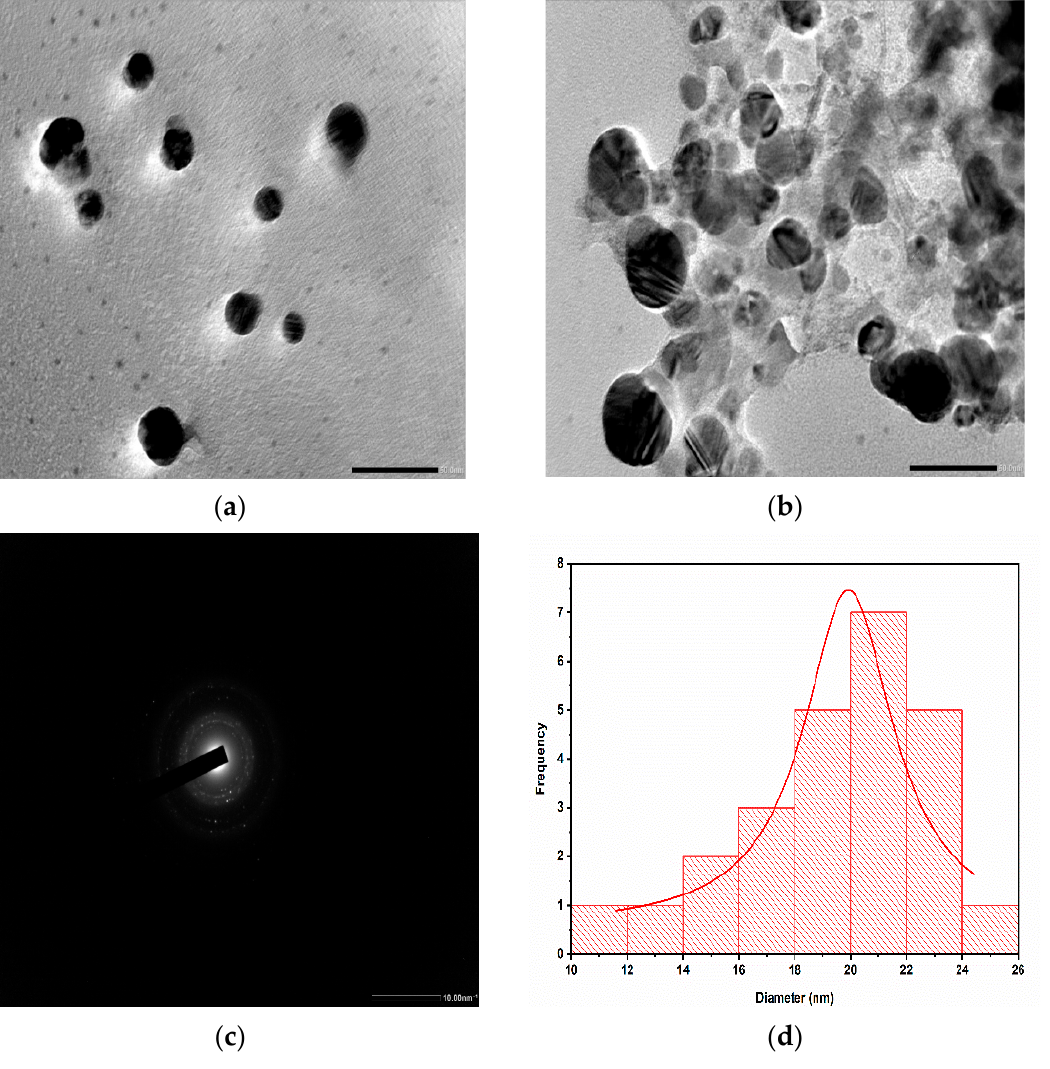
Figure 5. ( a , b ) HRTEM images of AgNPs in diverse magnification at ( a ) 20 nm scale ( b ) 50 nm scale ( c ) SAED pattern at 10 nm − 1 ( d ) the particle histogram . Table 2. FTIR analysis of Trigonella foenum-graecum L. leaves extract and biosynthesized AgNPs.